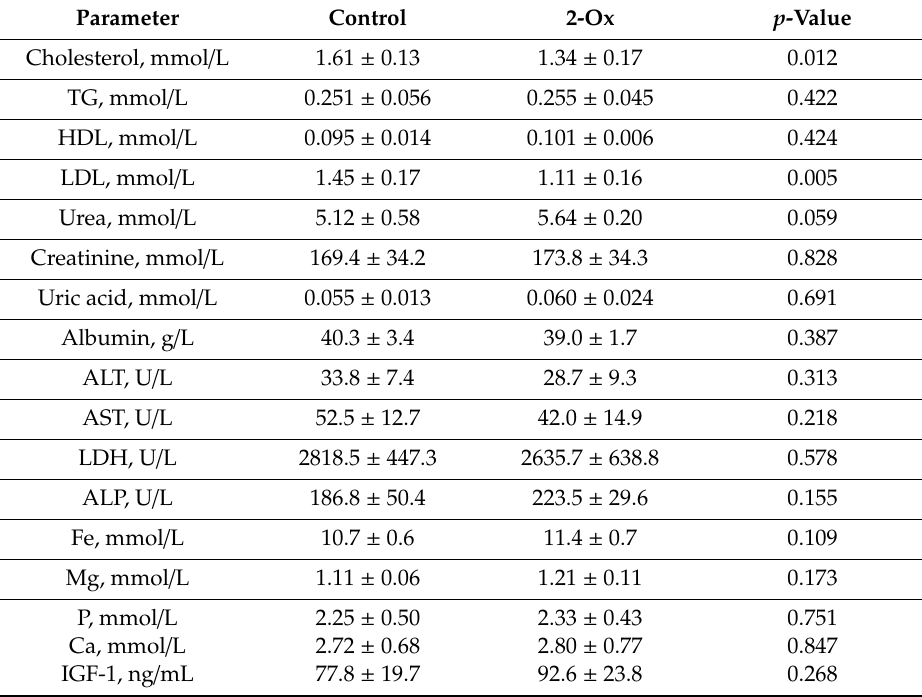
Table 4. Biochemical parameters and the IGF-1 concentration in serum obtained from control and 2-Ox-administered, nine-month-old, growth-retarded gilts.